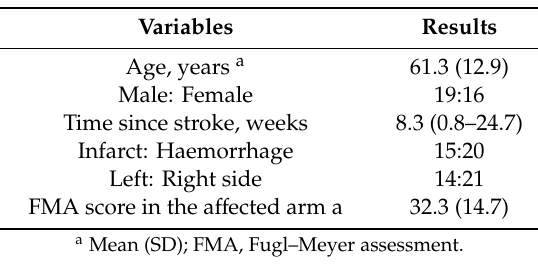
Table 1. The detailed clinical information about patients.